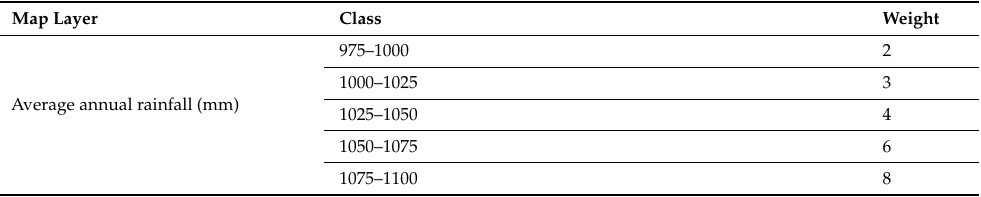
Table 2. Assigned weights to each class of selected thematic layers, based on their influence on the artificial groundwater